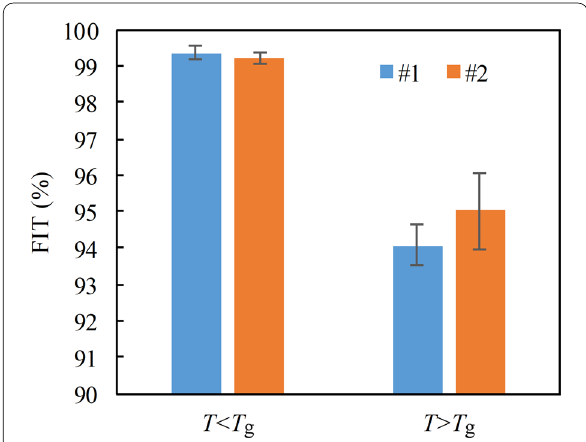
Fig. 15 FIT value obtained using Method 2